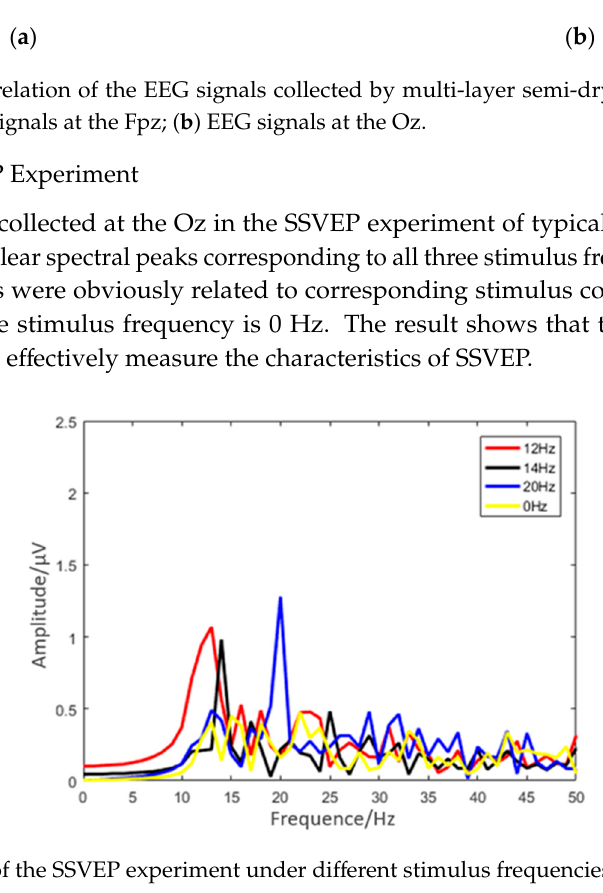
Figure 10. The correlation of the EEG signals collected by multi ‐ layer semi ‐ dry electrode and wet electrode: ( a ) EEG signals at the Fpz; ( b ) EEG signals at the Oz.